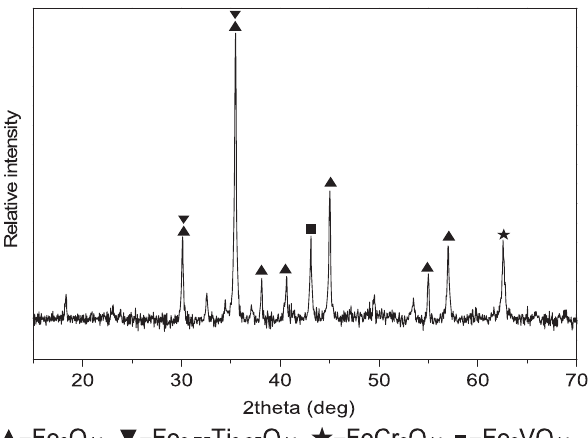
Figure 2: X-ray diffraction analysis of